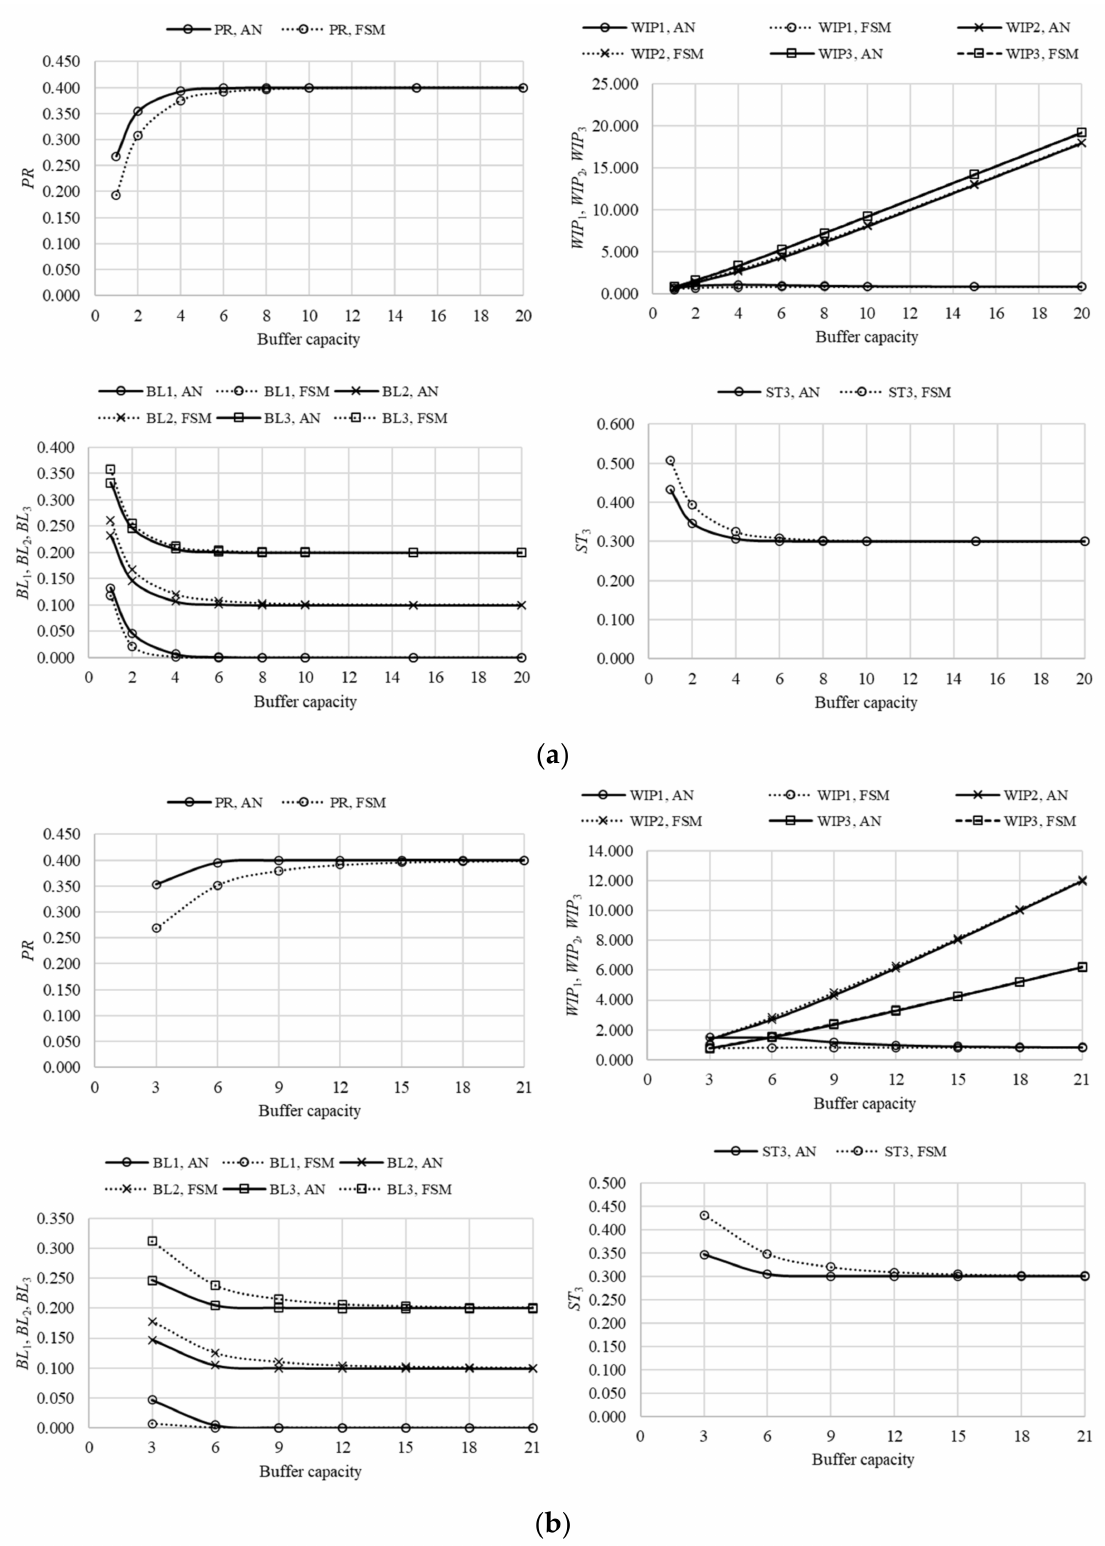
Figure 8. Comparison of the performance measures in the case of line L4C: ( a ) N 1 = N 2 = N 3 = N